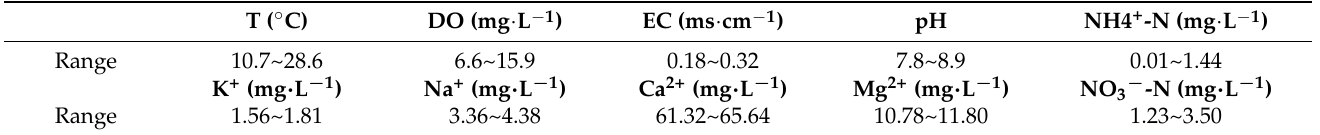
Table 1. Water chemical parameters in the WJD reservoir from our previous study [27].